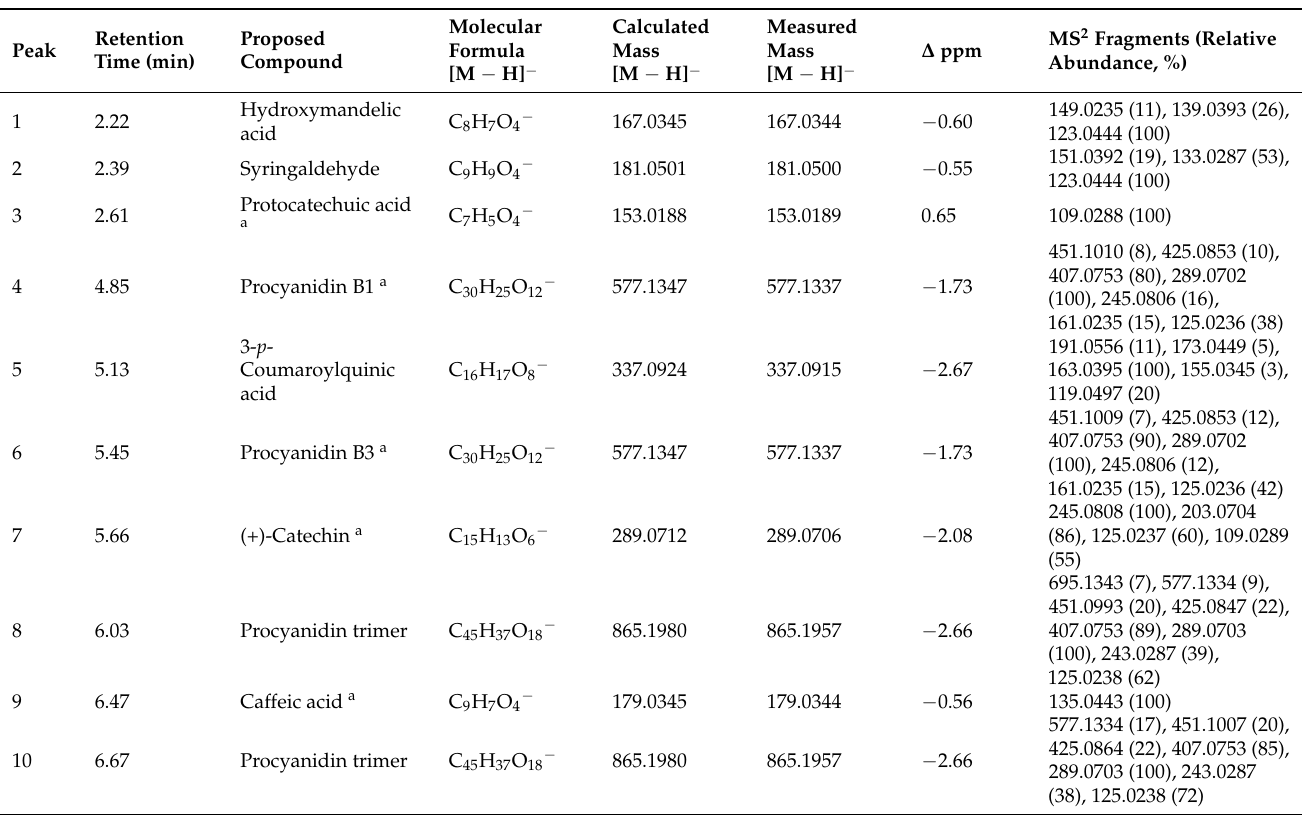
Table 1. Phenolic compounds identified in Pinus densiflora Sieb. et Zucc. bark extract (PBE) using a high-resolution UHPLC-Orbitrap mass spectrometer in negative ionized